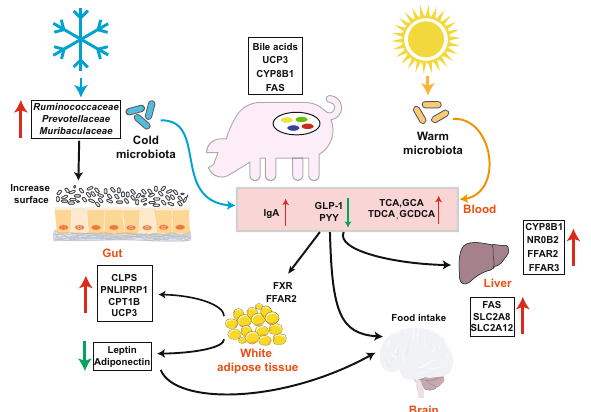
Fig. 8 Paradigm summarizing the crosstalk between the gut microbiota and the host via the gut microbiota-blood-liver and fat axes in mediating host thermogenesis under cold stress. FFAR2, free fatty acid receptor 2; FFAR2, free fatty acid receptor 3; UCP3, uncoupling protein 3; GLP-1, glucagon-like peptide-1; PYY, peptide YY; SCFAs, short-chain fatty acids; TCA, taurocholic acid; GCA, sodium glycocholate hydrate; TLCA, taurolithocholic acid; TDCA, taurodeoxycholic acid; CDCA, chenodeoxycholic acid; GCDCA, glycochenodeoxycholic acid; CYP8B1, cytochrome P450, family 8, subfamily b, polypeptide 1; NR0B2, nuclear receptor subfamily 0, group B, member 2; FAS, fatty acid synthase; SLC2A8, solute carrier family 2 (facilitated glucose transporter) member 8; SLC2A12, solute carrier family 2 (facilitated glucose transporter) member 12; FXR, farnesoid X receptor; CLPS, colipase; CPT1B, carnitine palmitoyltransferase 1B. The elements, such as snow fl ake, sun, liver, and brain, were used from BioRender-biorender.com